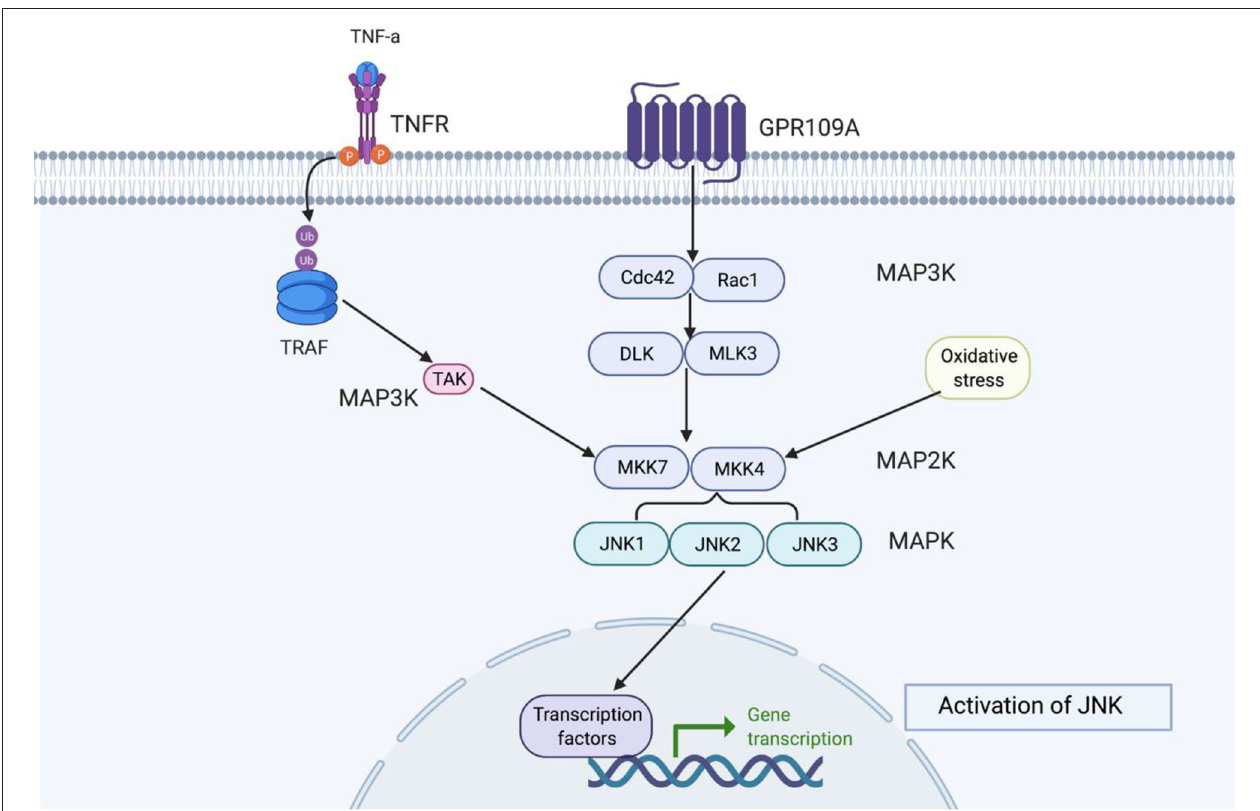
FIGURE 6 | This figure shows how JNK functions in the signalling cascade. Depending on the extracellular signal, there are different MAPKKK proteins, but MAKK and MAPK remain constant. MAPKKK is always a precursor to MAPKK and MAPK, respectively. c-Jun N-terminal kinases (JNKs) belong to stress-activated protein kinases (SAPKs) and are part of the MAPK signalling cascade group, which are involved in signal amplification ( 118). JNK are activated by stress signals such as hyperosmolarity and heat shock, oxidative stress, UV and ionising radiation, pro-inflammatory cytokines, TNF- α , and IL-1B (119, 120). JNK activity is highest in the brain compared to other non-neural tissues (121, 122). JNK protein are encoded by three genes, JNK1 (Mapk8), JNK2 (Mapk9), and JNK3 (Mapk10). Where JNK1 and JNK2 are expressed ubiquitously in all mammalian tissues and JNK3 is restricted to the heart, testis, and brain (123). The highest level of JNK1-3 mRNA are found in the neocortex, followed by the hippocampus, thalamus, and midbrain (124). Downstream JNK are transcription factors such as c-Jun, c-fos JunD, ATF-2, and ELK-1, which can become activated when exposed to stress signals (